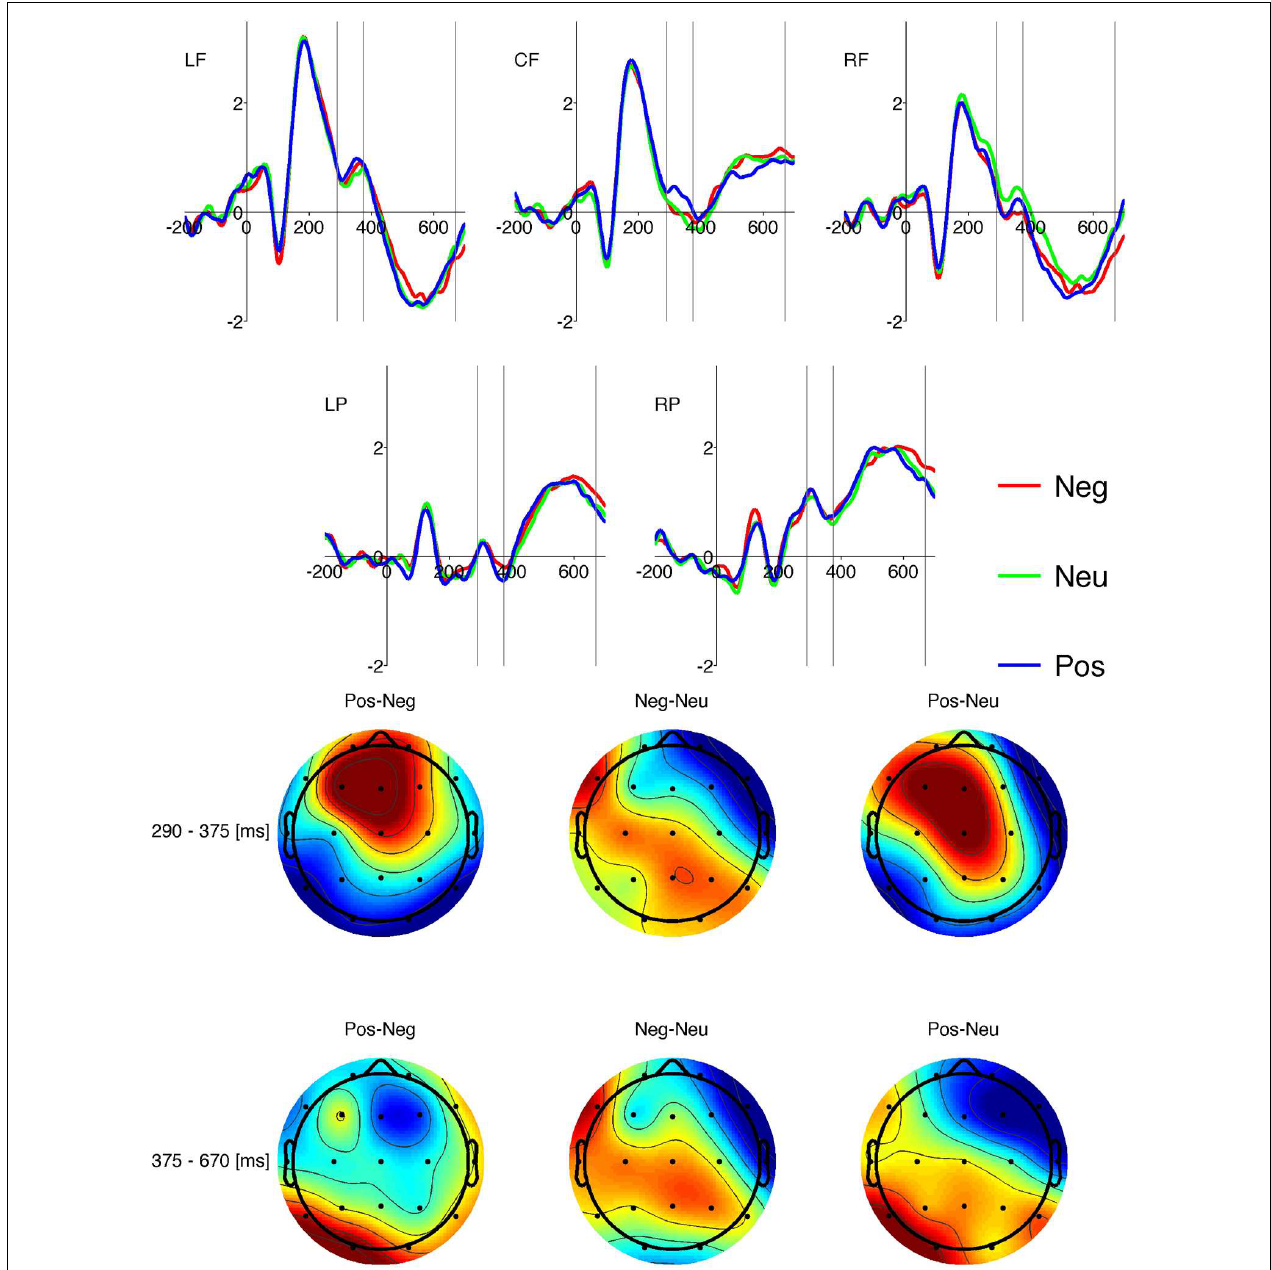
FIGURE 3 | Upper plots show grand average amplitudes of ERPs for different levels of valence (red: negative; green: neutral; blue: positive) at the five ROIs (LF: left frontal; CF: centro-frontal; RF: right frontal; LP: left posterior; RP: right posterior). Vertical lines indicate the two time windows of interest. Lower plots show the topographical distribution of differences in amplitudes between the valence levels displayed above each plot. The color scale is red for positive and blue for negative value of the difference. Upper row show data for the 290-375 ms time window, lower row shows data for the 375-670 ms time